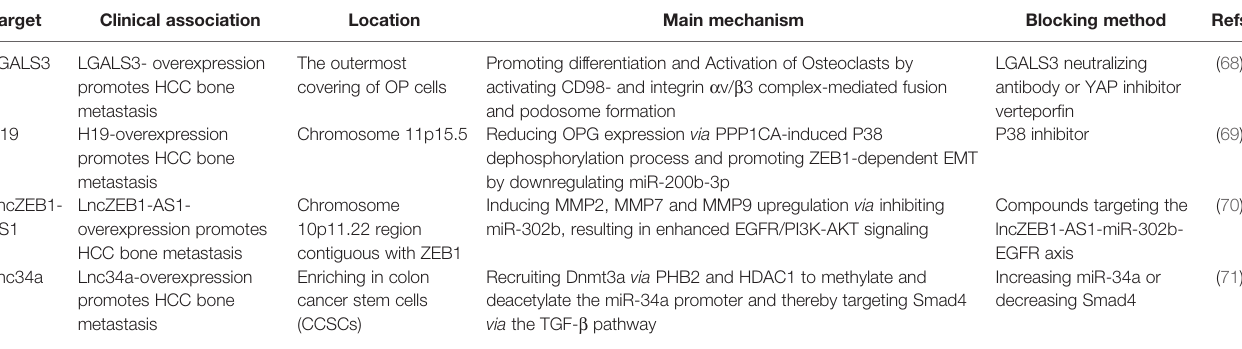
TABLE 2 | Recent advances in molecular mechanisms and oncogenes in